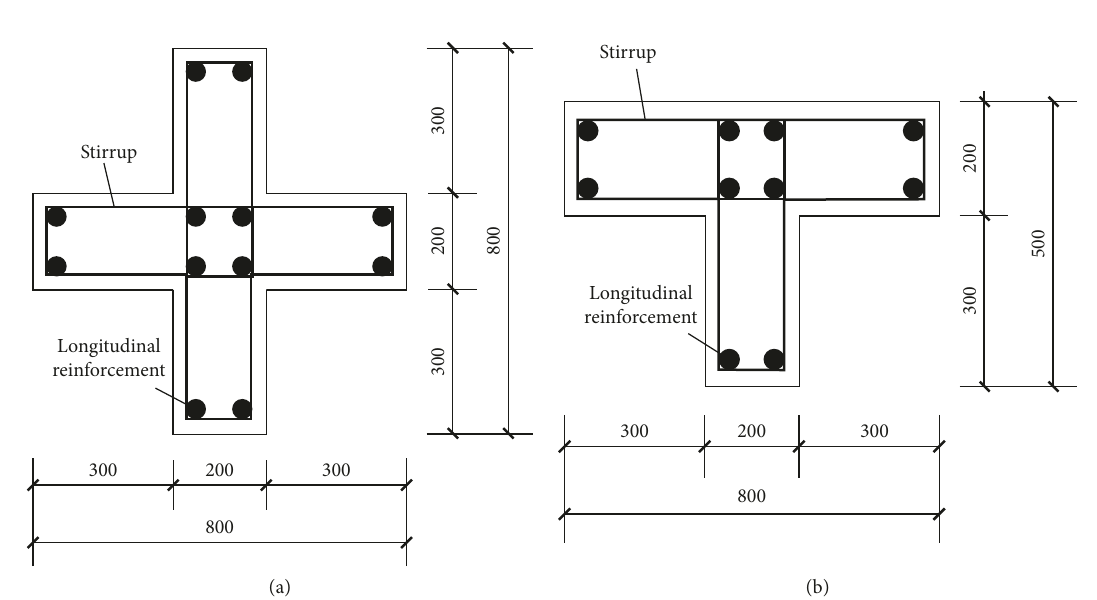
Figure 1: Cross sections of the specially shaped columns. (a) Cross-shaped columns. (b) T-shaped columns.